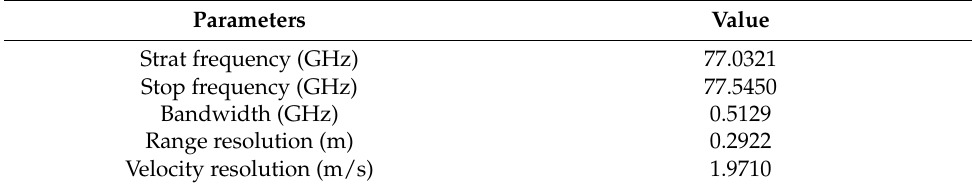
Table 5. Radar parameter settings.